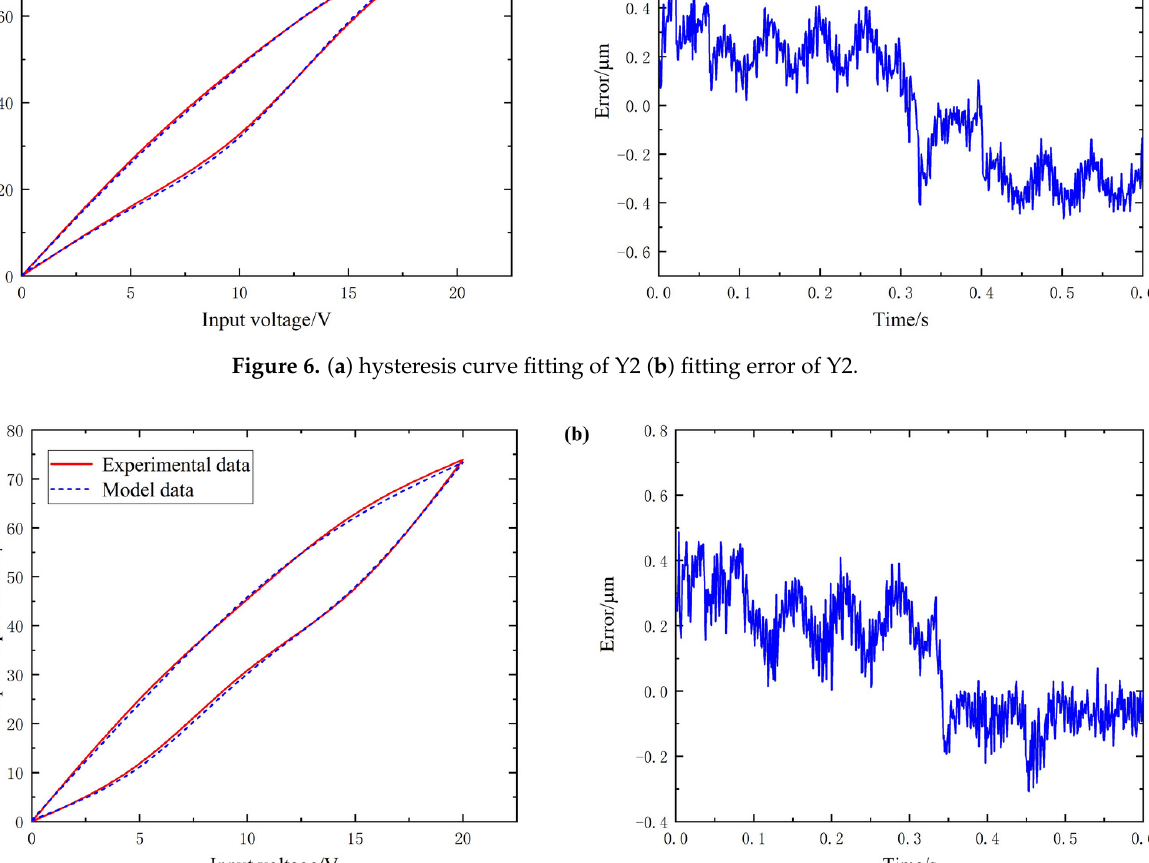
Figure 7. ( a ) hysteresis curve fitting of Z ( b ) fitting error of Z.